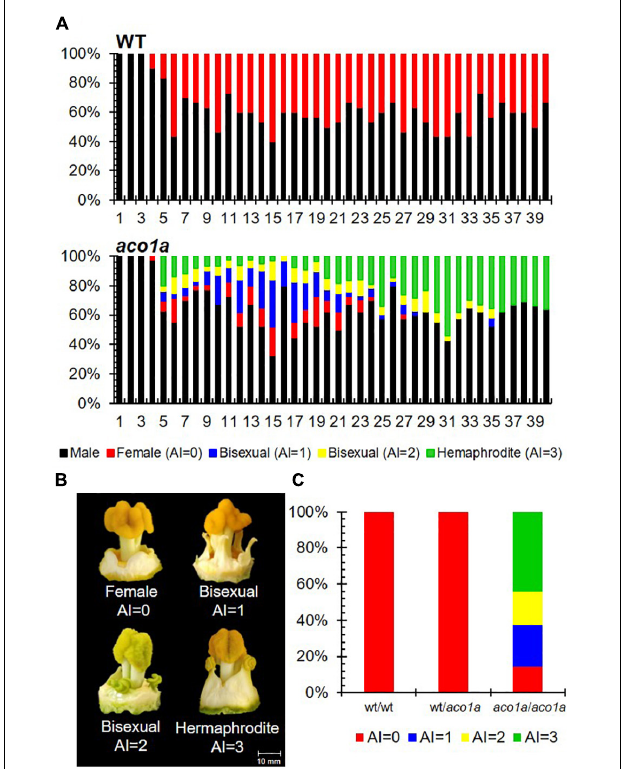
FIGURE 1 | Sex phenotype of WT and aco1a plants. (A) Distribution of male and pistillate flowers in the first 40 nodes of the main shoot. In each node, color bars indicate the percentages of male (black), female (red), and bisexual and hermaphrodite flowers (blue, yellow, and green) in the total number of plants analyzed ( n = 30 for each genotype). (B) Phenotype of pistillate flowers with different stamen development and AI index. Female flowers (AI = 0) develop no stamen, bisexual flowers (AI = 1–2) develop intermediate stamens, and hermaphrodite flowers (AI = 3) develop entire stamens with